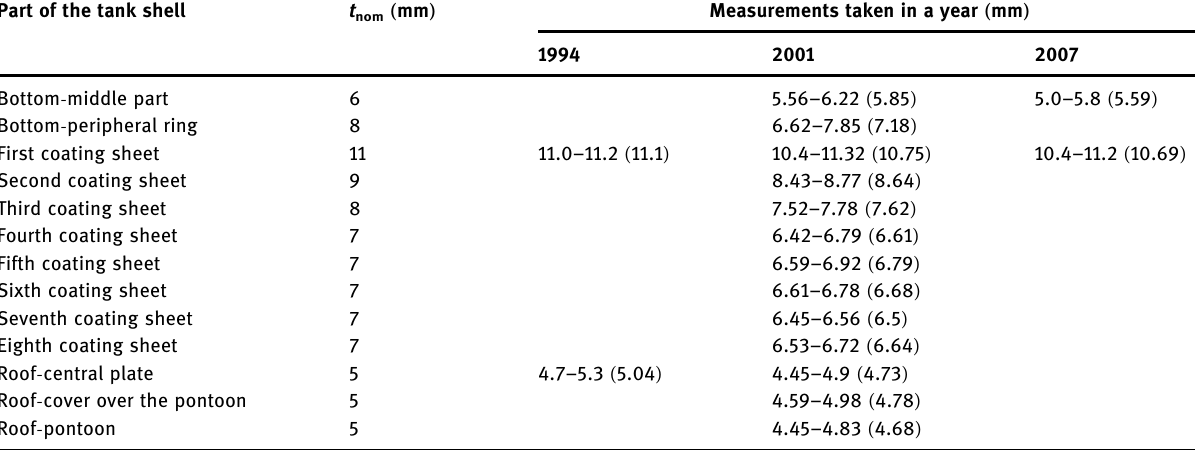
Table 2: Sheet thicknesses measured at di ff erent times in di ff erent locations of the tank number 2 steel shell Part of the tank